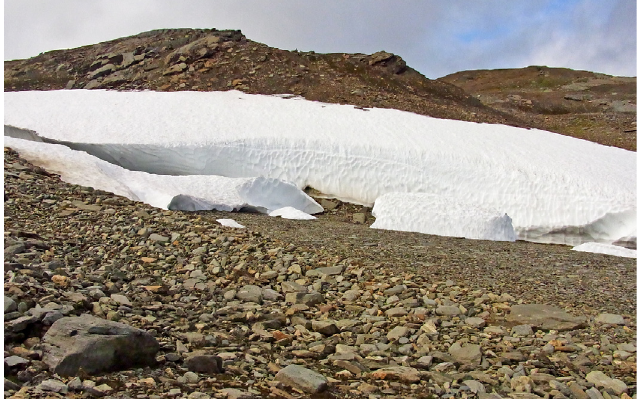
Figure 16: Låktatjåkka snow/ice patch